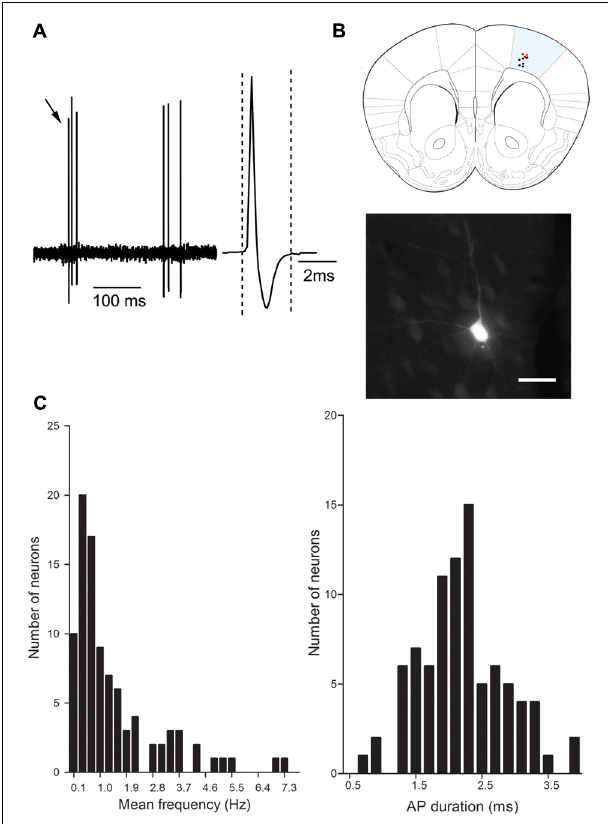
FIGURE 2 | Electrophysiological characteristics of M1 neurons. (A) Representative electrophysiological trace of a cortical neuron. Note the presence of triplet of spikes (black arrows).The inset represents the action potential shape (averaged over 5 min recording), the action potential duration is measured between the two dashed lines. (B) Schematic representation of the distribution of recorded neurons in M1 1.4 mm anterior to Bregma, neurobiotine labeled neurons (red dots) and non labeled neurons (black dots). Photomicrograph shows a representative example of neurobiotine labeled neuron. Scale bar represents 20 μ m. (C) Distribution of the mean frequency (Hz) and AP duration (ms).